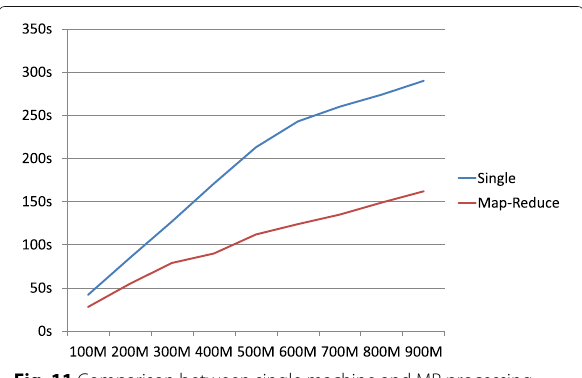
Fig. 11 Comparison between single machine and MR processing